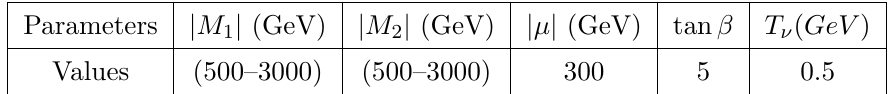
Table 1 . Relevant input parameters for the parameter-space scan have been presented. Other parameters kept at (cid:12)xed values include: M R = 100 GeV, B M = 10 (cid:0) 3 GeV 2 , M 3 = 2 TeV, M Q